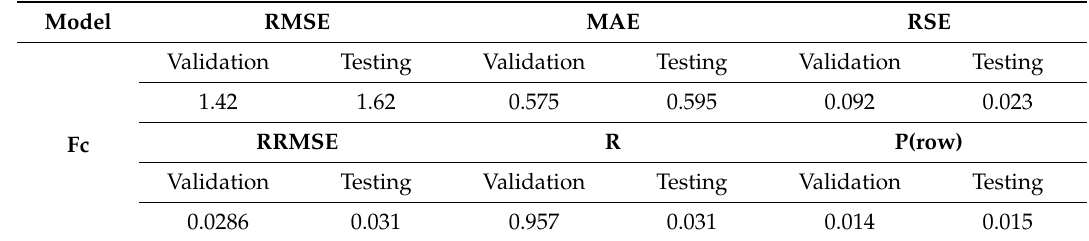
Table 8. Statistical calculations of the proposed Table 8 . Statistical calculations of the proposed model .